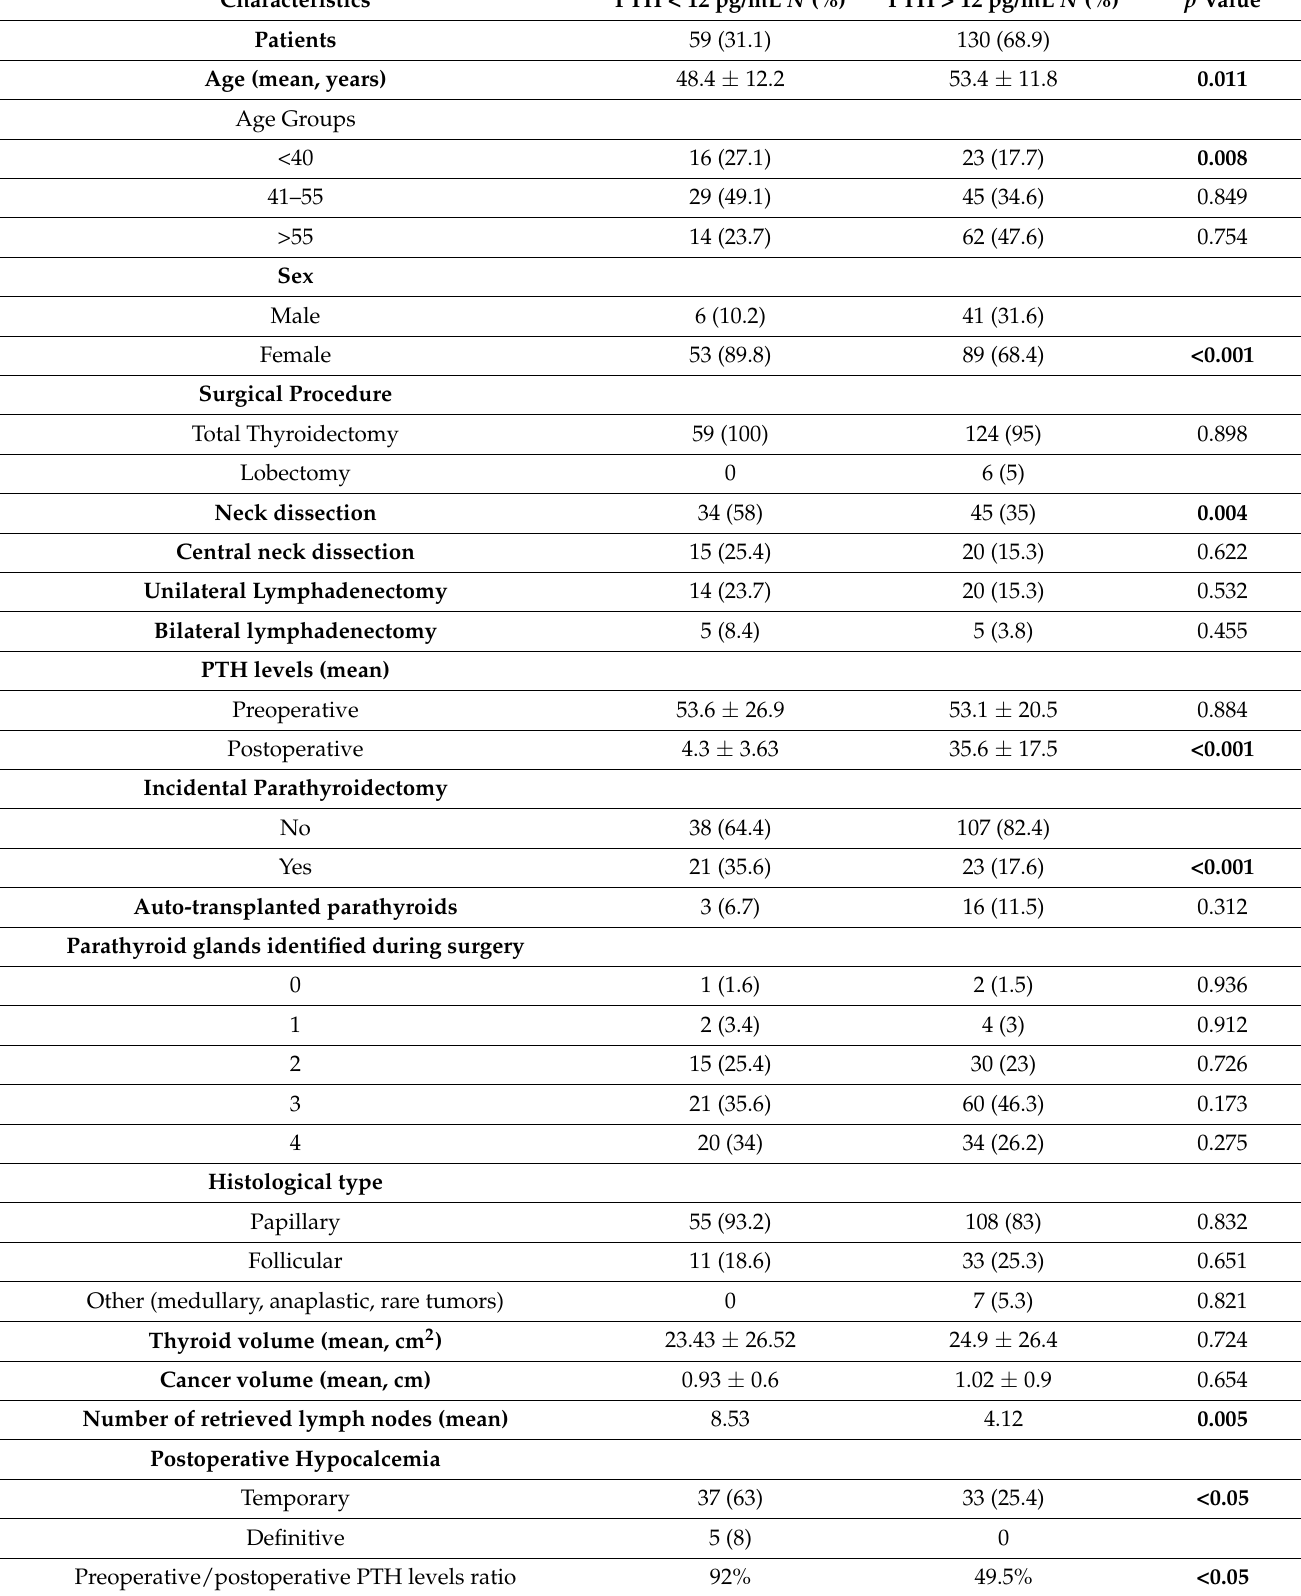
Table 2. Risk factors for low level of postoperative